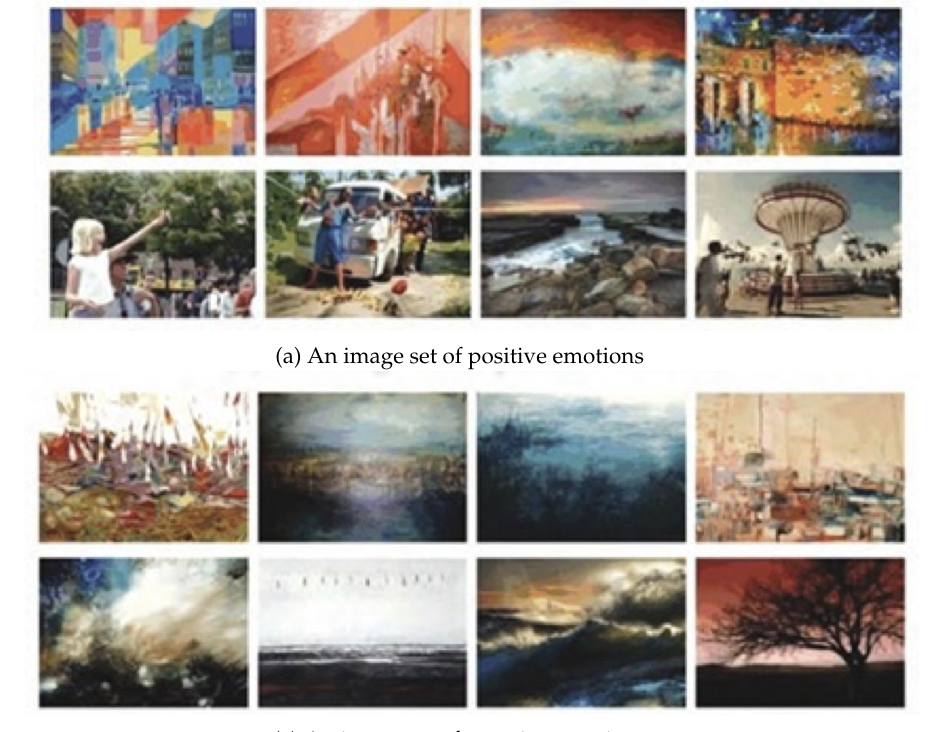
Fig. 4. The schematic figures of image sentiment